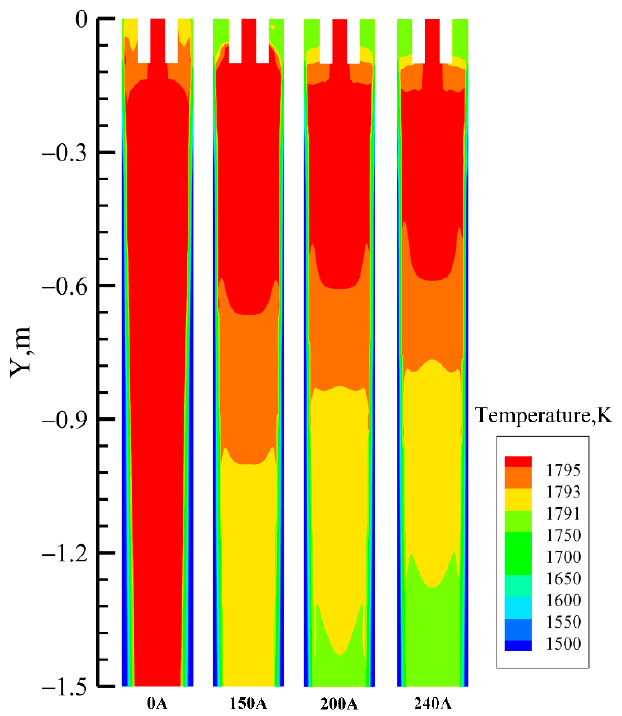
Figure 8. The temperature profile on the plane of Z = 0.